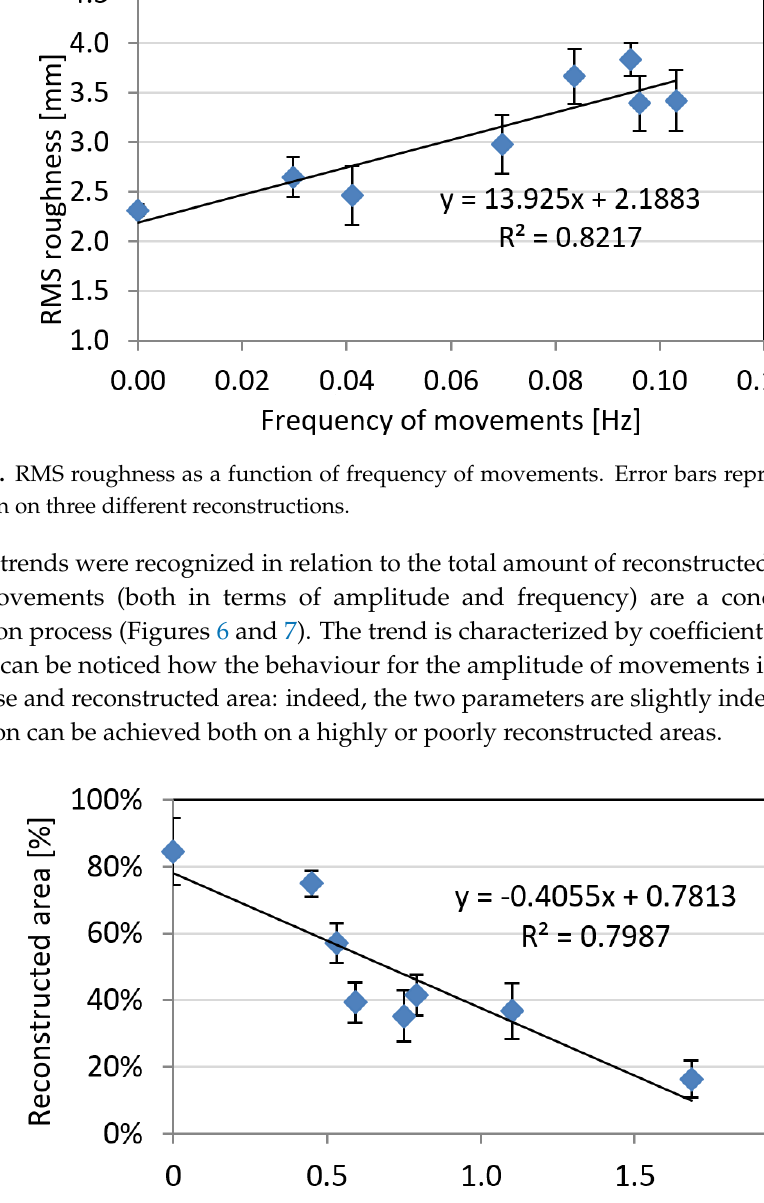
Figure 6. The reconstructed area rate as a function of average estimated animal movements’ amplitude. Error bars represent standard deviation on three different reconstructions.